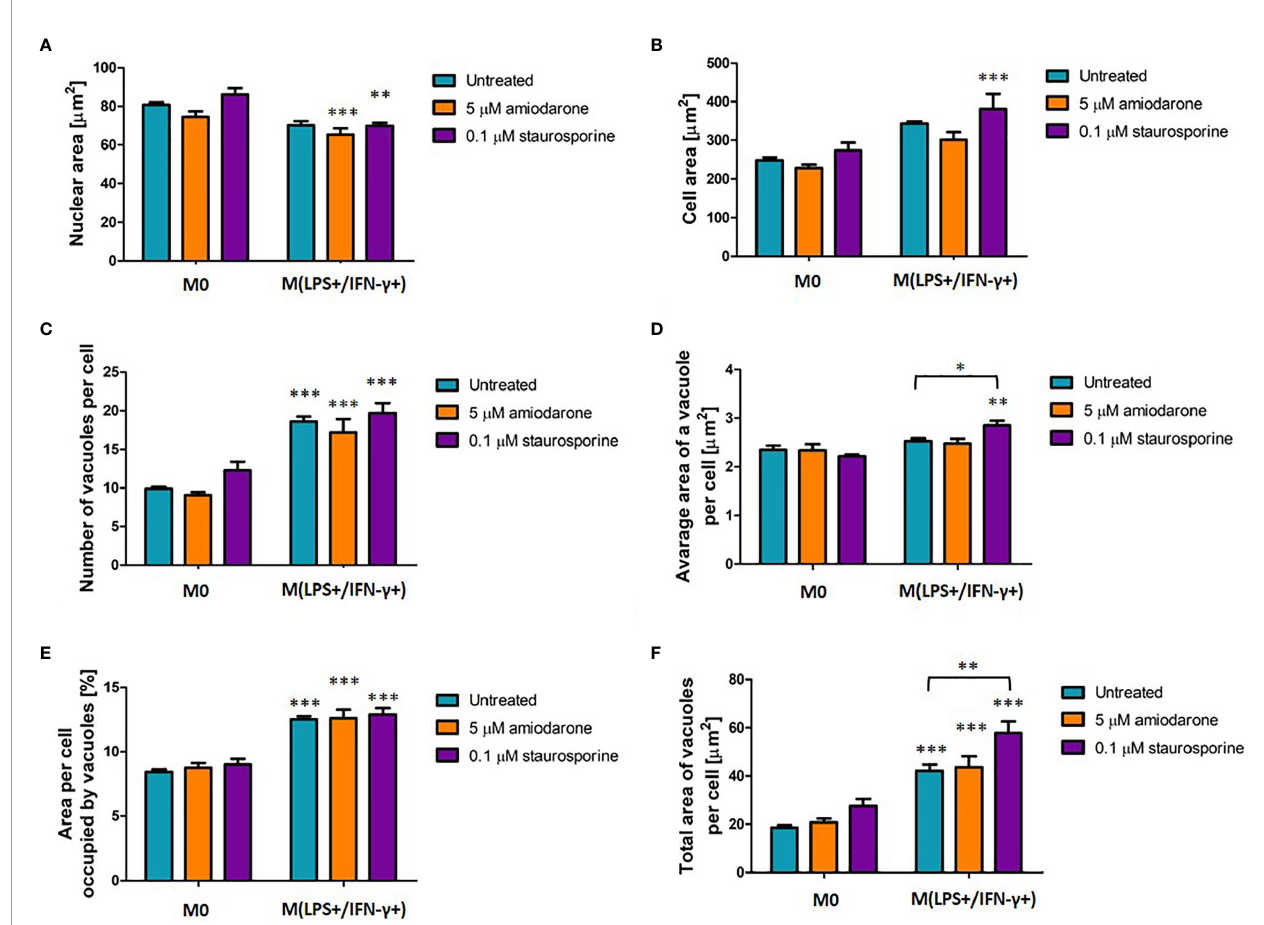
FIGURE 6 | Morphological characteristic of M0 and LPS+/IFN- g + activated NR8383 rat macrophages after 24 h exposure to 5 µM amiodarone (orange bars) and 0.1 µM staurosporine (purple bars). Nuclear area (A) , cellular area (B) , number vacuoles per cell (C) , average area of a single vacuole (D) , cellular area occupied by all vacuoles (E) and total area of all vacuoles per cell (F) were quanti fi ed in non-polarized macrophages (M0) and LPS+/IFN- g activated [M(LPS+/IFN- g +)] cells followed by 24 h activation with FAM. Data are normalized to number of cells and presented as mean values ± SEM of three separate experiments. Statistical comparisons are made using a one-way ANOVA analysis with Bonferroni ’ s multiple comparison post-hoc test. Results are compared to non-polarized control (M0) (except otherwise indicated) and statistical signi fi cance is marked as follows: * indicate p < 0.05, ** indicate p < 0.01, *** indicate p <